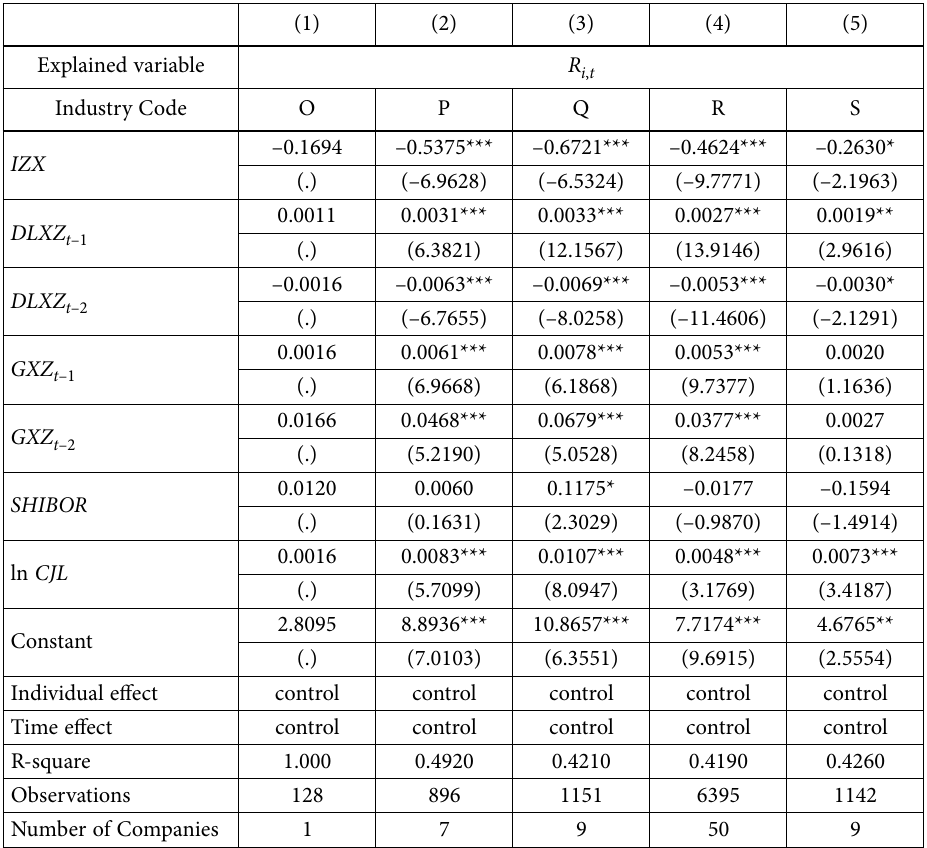
Table 7. Impact of infodemic on stock market